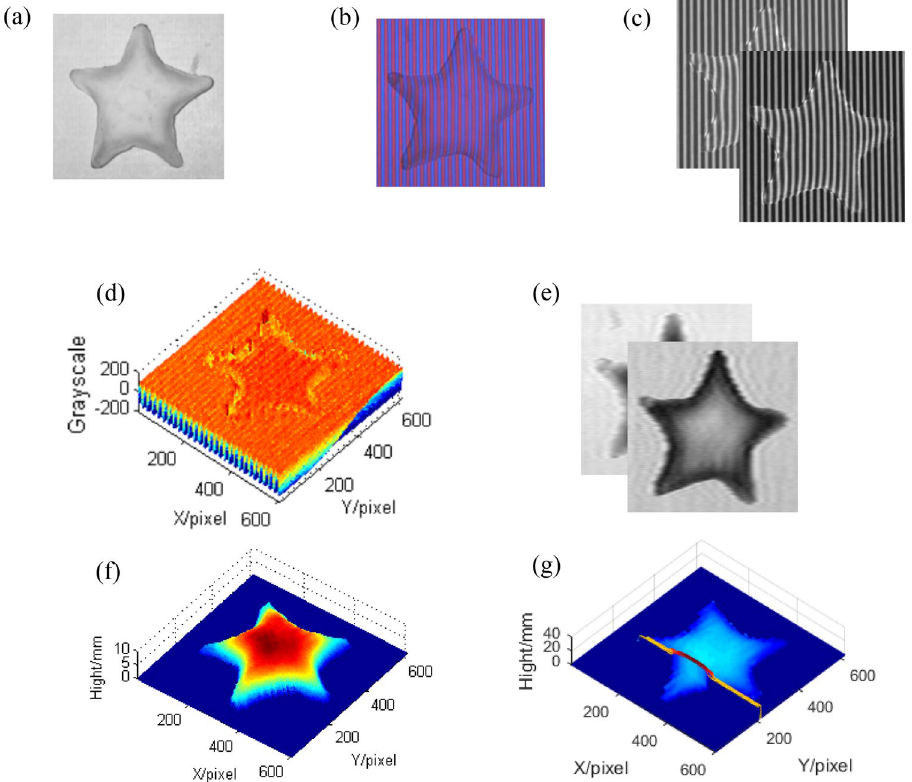
Figure 5. The reconstructed results of the star: ( a ) the measured star; ( b ) the color deformed pattern; ( c ) the normalized red and blue components; ( d ) the AC component of the red normalized deformed pattern; ( e ) Moiré0 and Moiré90 fringes; ( f ) the reconstructed star with normalization and binary mask; ( g ) the reconstructed star without normalization and binary mask.